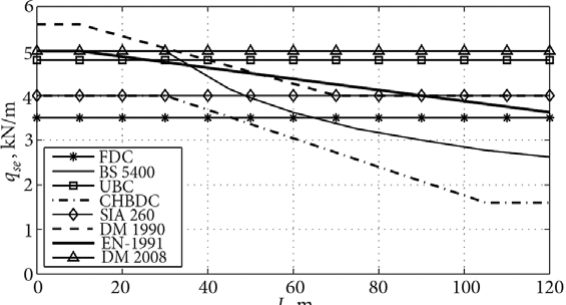
Fig. 2. Live load (nominal) prescribed by different Standards as a function of span